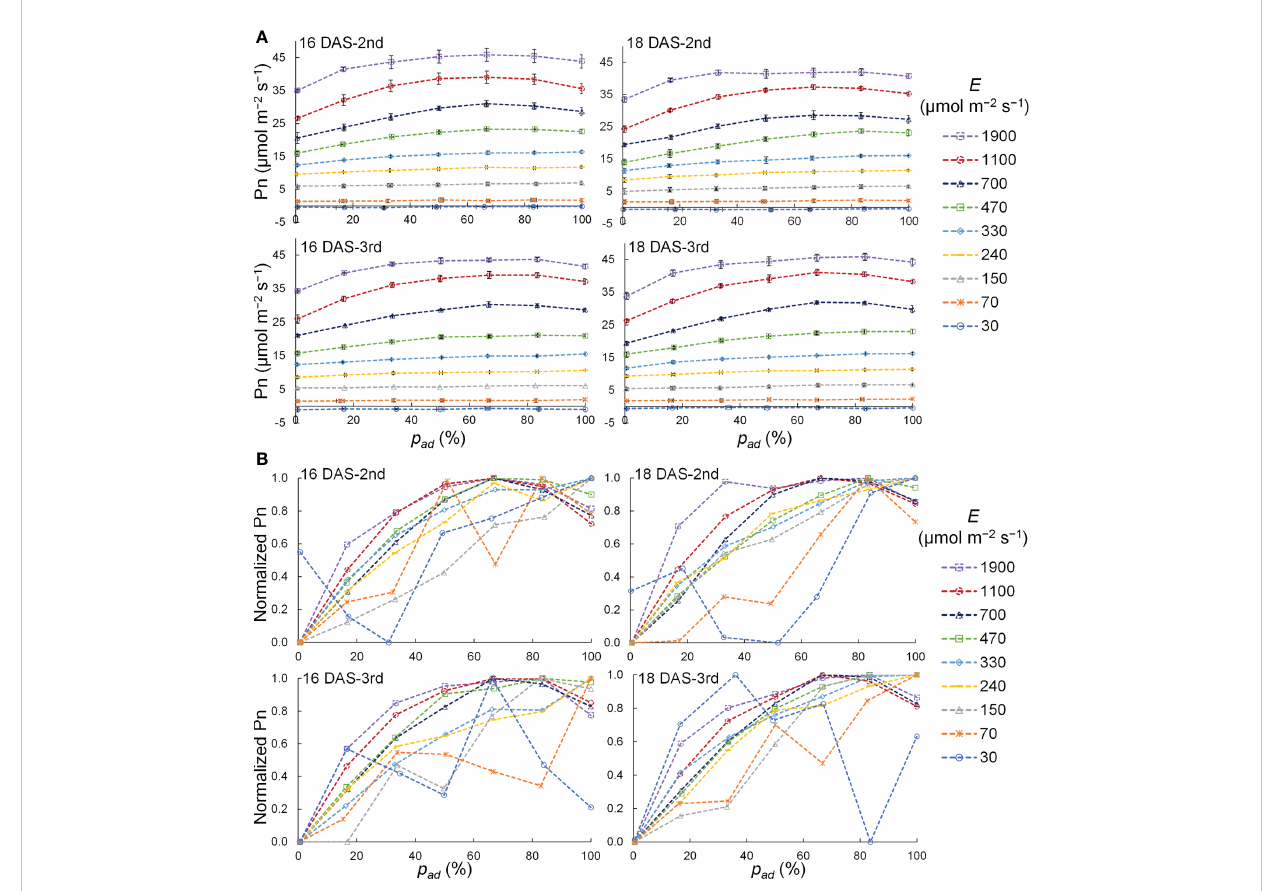
FIGURE 8 Relationship between the proportion ( p ad ) of the photosynthetic photon fl ux density (PPFD) on a leaf adaxial surface to the total PPFD on the adaxial and abaxial surfaces of a leaf ( E ) and net photosynthetic rate (Pn) (A) as well as normalized Pn (B) of the 2nd and 3rd leaves of komatsuna 16 DAS and 18 DAS with different E. In (A) , these plots represent the average values, and the horizontal and vertical lines represent standard error at each condition ( n = 2 – 5). In (B) , the plots represent the normalized values that were calculated by normalizing the Pn values at each E